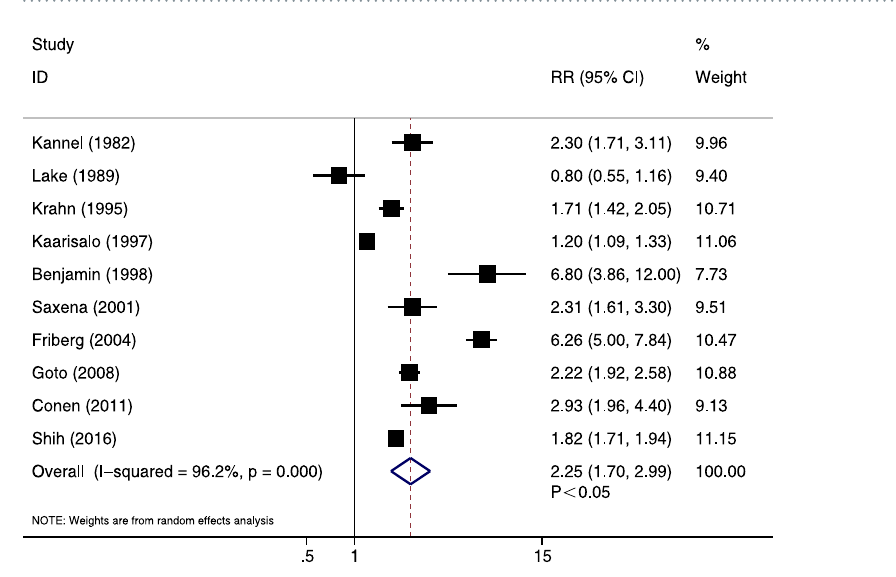
Figure 4. Forest plot showing the comparison between AF and non-AF patients in the pooled analysis of crude relative risk for cardiovascular